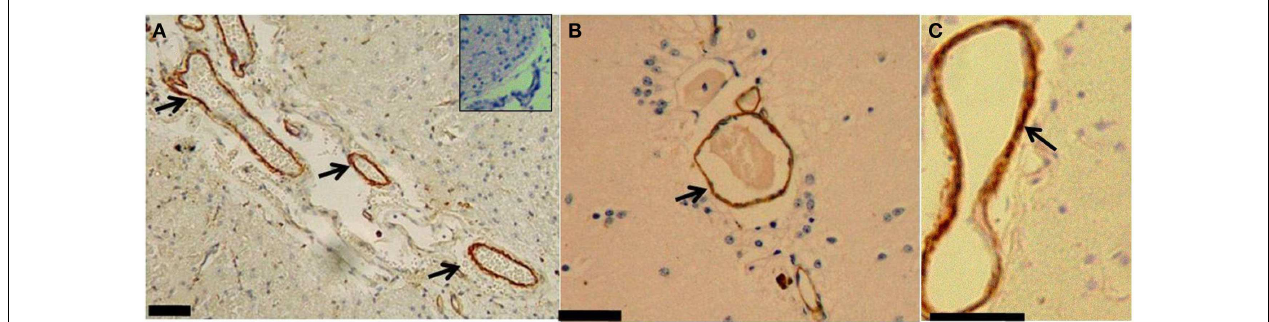
with nonsense rabbit serum. (B) The occipital lobe of an Aged-matched subject (subject 10749); and (C) the hippocampus (subject I1112) arrows indicate deposition of the A β 42 inside the walls of small veins. Scale bars: 60 µ m.